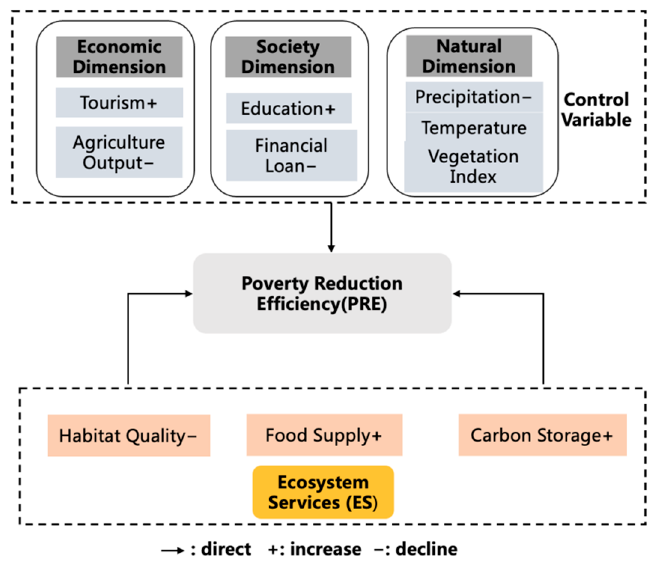
Figure 6. The impact mechanism of PRE on ES.